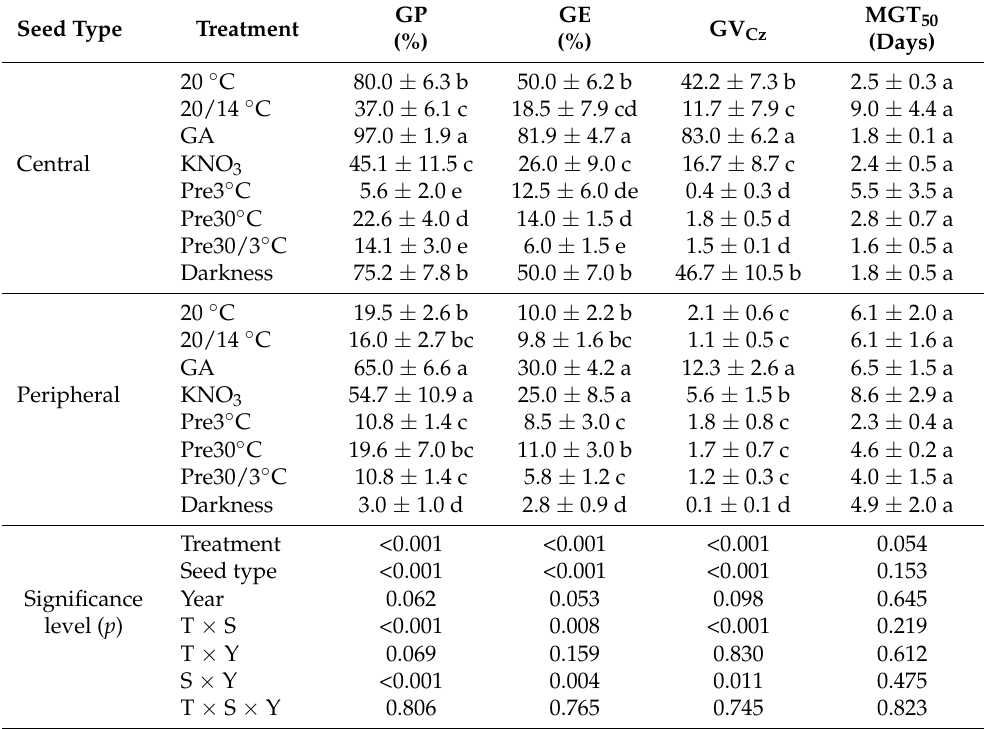
Table 4. Mean values ( ± SE) and statistical significance of the germination parameters assessed at different germination and pre-germination treatments, in the lab and under white light, except for the treatment of darkness. Averages for seeds collected in June 2005 and June 2006 are shown as a